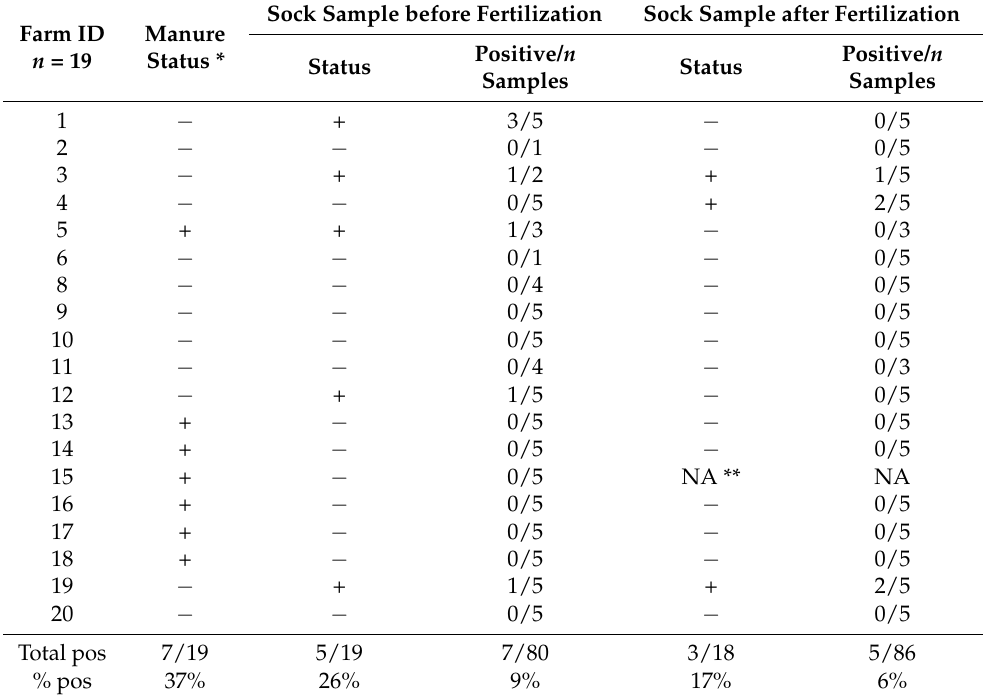
Table 2. MRSA status of manure and sock